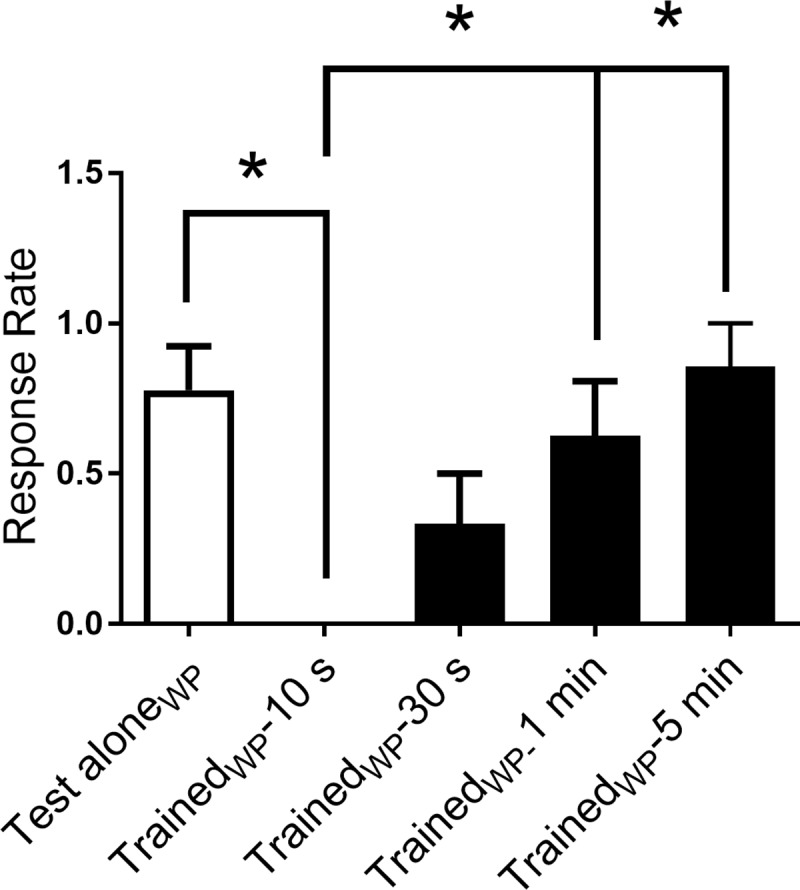
Stimulation of the head of larval zebrafish with water pulses induces rapid habituation.Effect of water pulses delivered at 1 Hz on the touch-induced C-start. All groups, except one (Test AloneWP, n = 9), were given posttests at various times after habituation training to determine the duration of the habituation with water pulses. The Test AloneWP group received the test stimuli without habituation training. A between-groups ANOVA yielded a significant group effect (F[4, 36] = 5.66; p < 0.05). Tukey HSD post-hoc tests revealed that the TrainedWP-10 s group (n = 8) was significantly less responsive than the Test AloneWP group (n = 9), the TrainedWP-1 min (n = 8), and the TrainedWP-5 min (n = 7) group. The TrainedWP-10 s group was not statistically different from the TrainedWP-30 s group (n = 9).